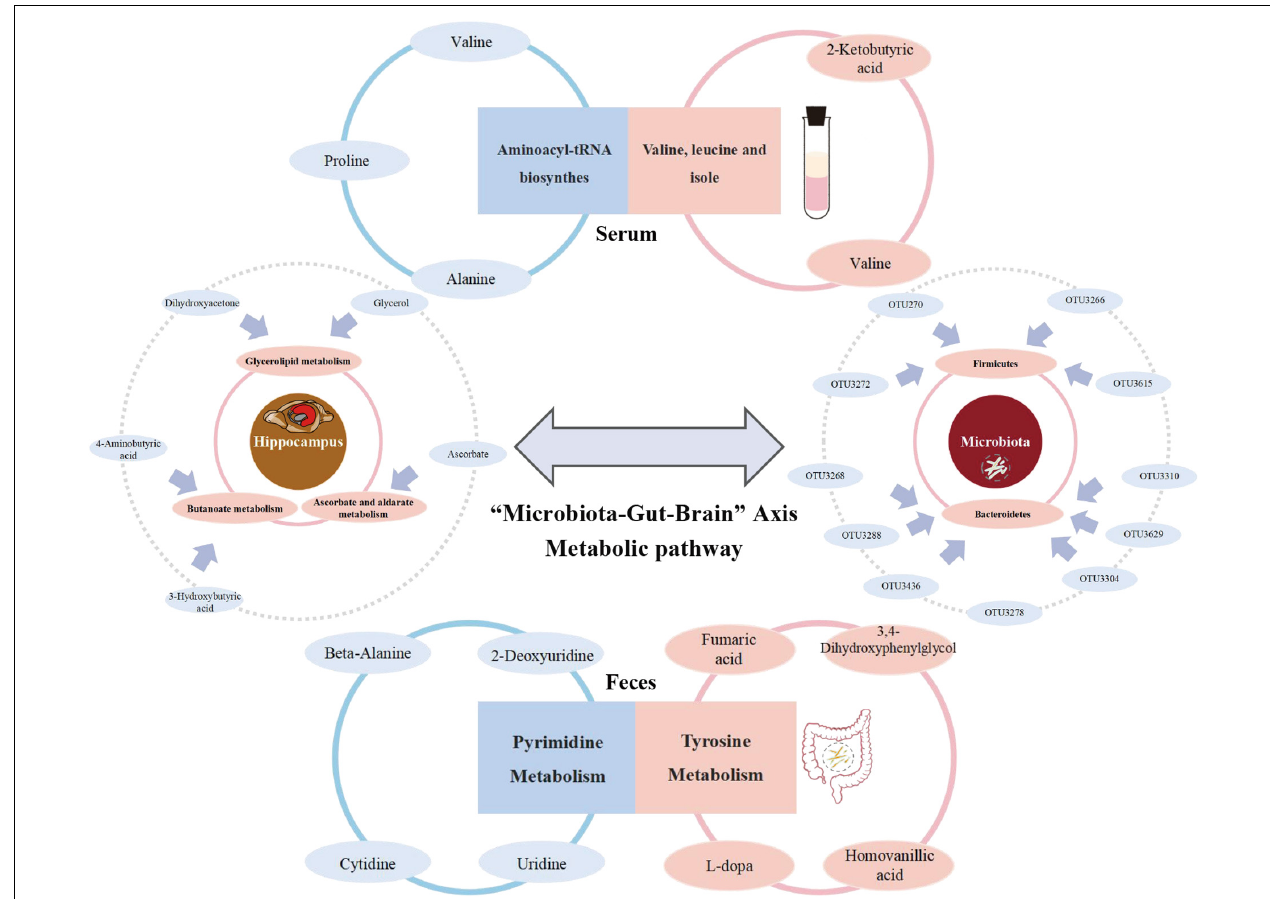
FIGURE 6 | Summary of the metabolism in which reversed metabolites are mainly enriched among “Microbiota-Gut-Brain” Axis during the development of MG comorbid